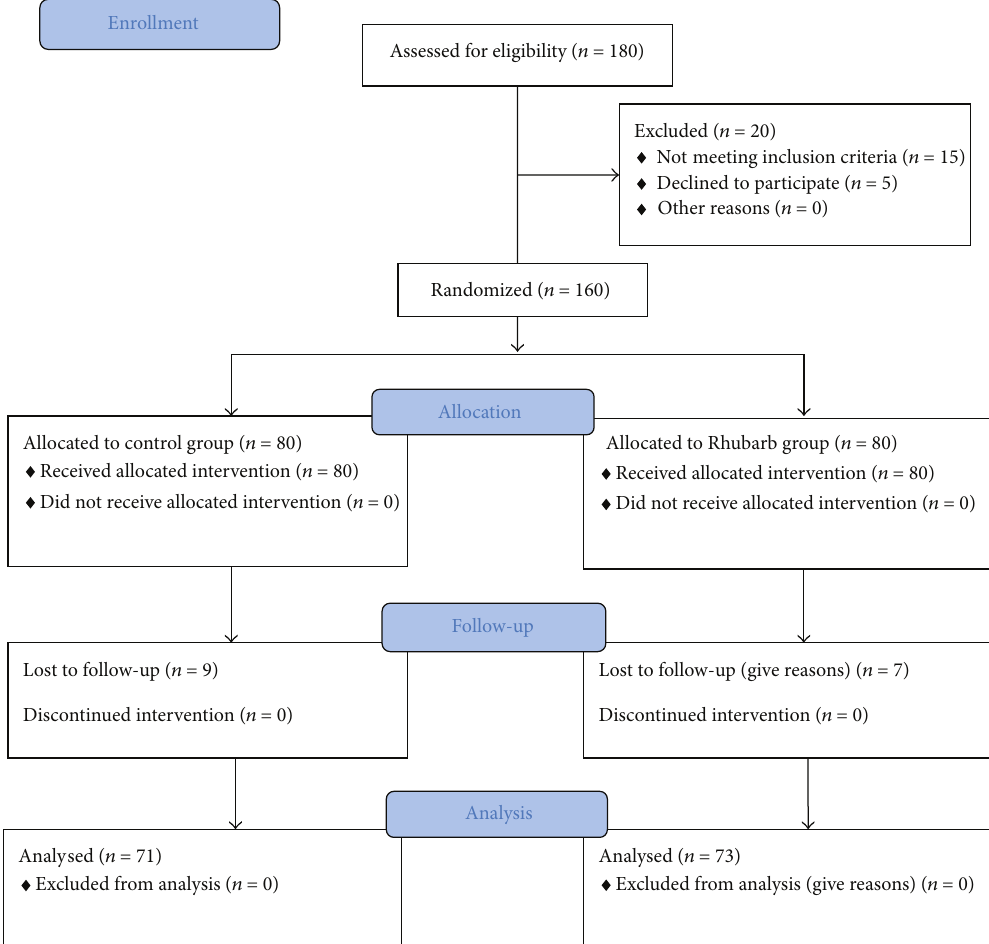
Figure 1: It shows recruitment, allocation, and follow-up of